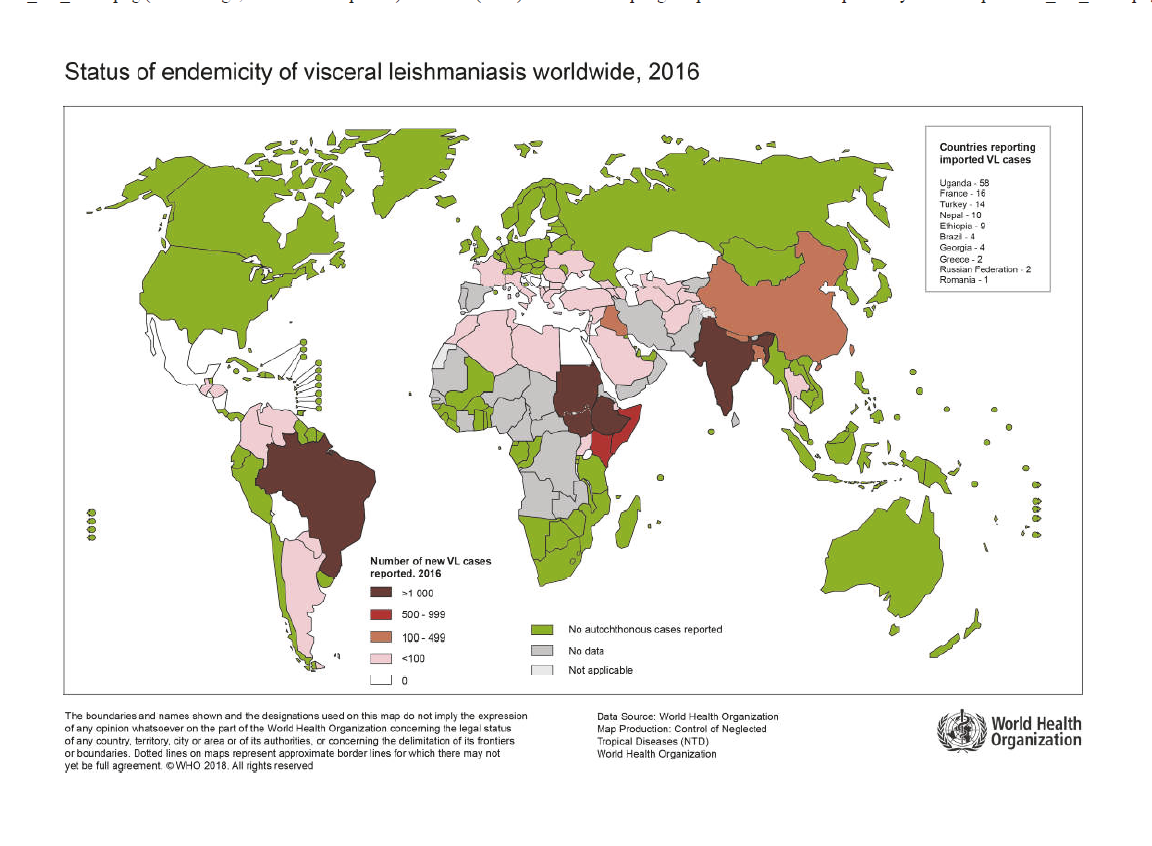
Figure 2: Status of visceral leishmaniasis worldwide 2016